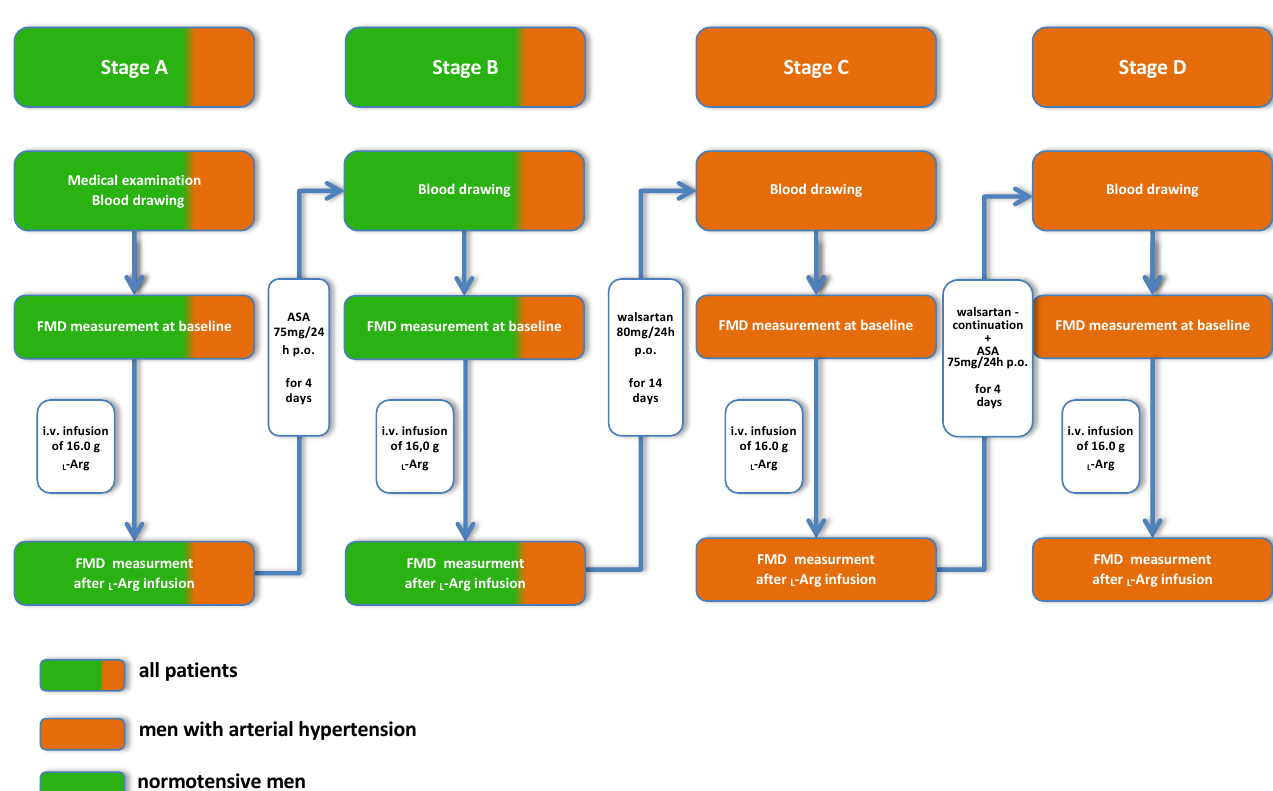
Figure 3. A flow chart—study design—schematic presentation of the study protocol. ASA—acetylosalicic acid; L -Arg— L - arginine; FMD—Flow-mediated